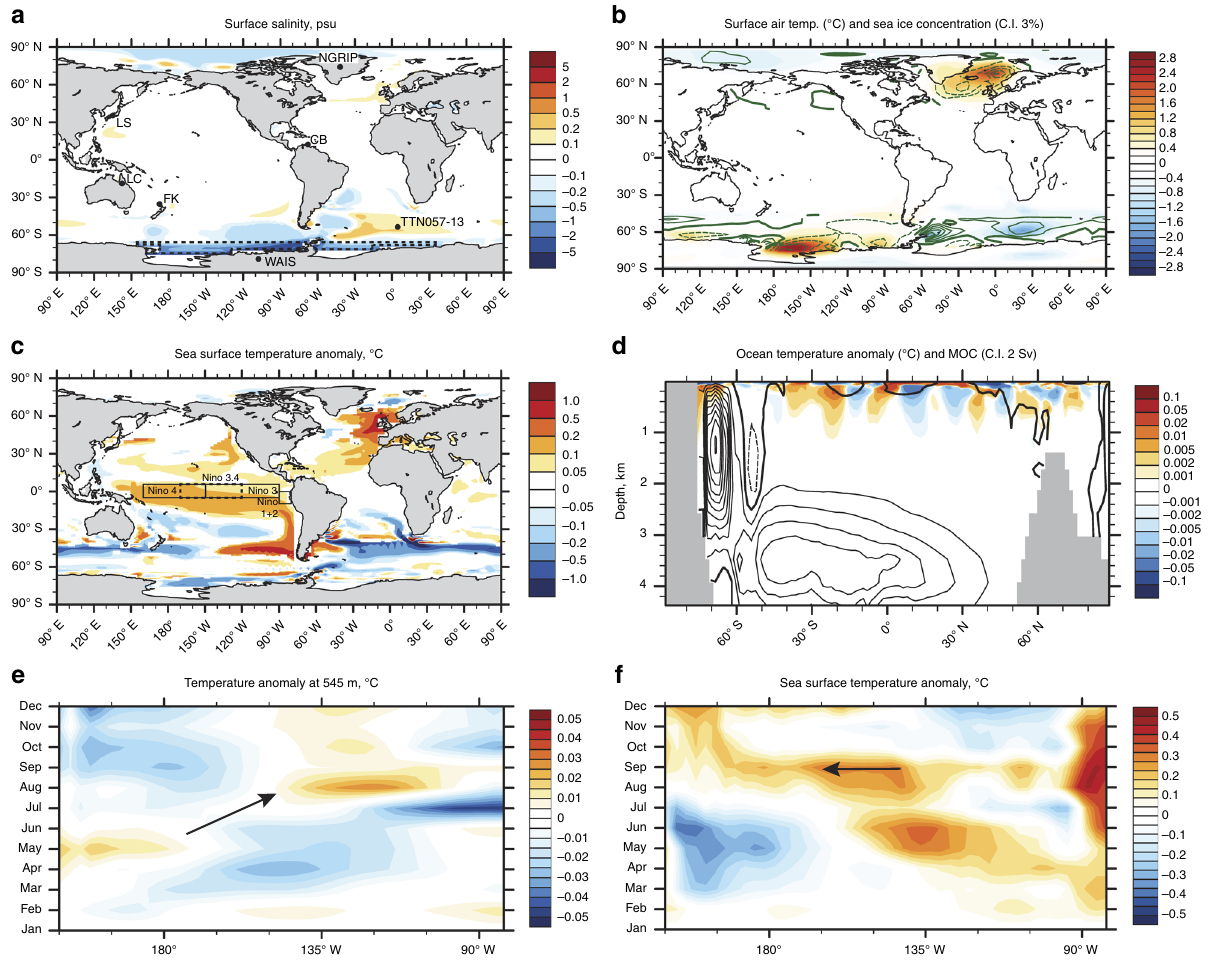
Fig. 3 Summary of CSIRO Mk3L ensemble simulations showing the impact of a 338-year duration freshwater fl ux of 0.54 Sv into the Weddell and Ross Seas. Salinity anomaly is shown in a ( dashed lines denote regions where freshwater applied with key site locations discussed in text shown). Surface air temperature ( colour ) and sea ice concentration anomalies ( green lines ; solid = positive, dashed = negative, with a contour interval of 3%) seen in b are not well-correlated with SST anomalies c , but sea ice concentration increases are highly correlated with salinity decreases in the Ross and Amundsen Sea sectors from the freshwater hosing. Global Meridional Overturning Circulation (MOC) anomaly is shown along with ocean temperature anomalies in d , where positive contours are solid, negative contours are dashed and the zero contour is emboldened, with a contour interval of 2 Sverdrups (Sv). The Southern positive cell represents reduced Antarctic Bottom Water (AABW) formation. Anomalies in a – d are averaged over the 338-year